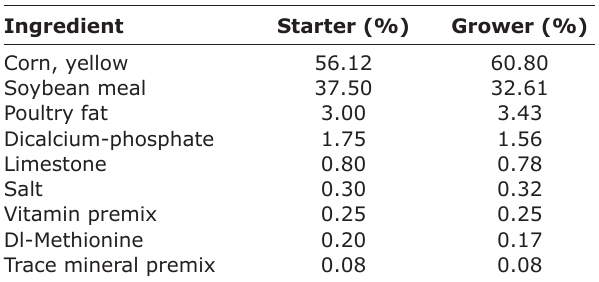
Supplementary Table-2: Composition of probiotic Protexin ®